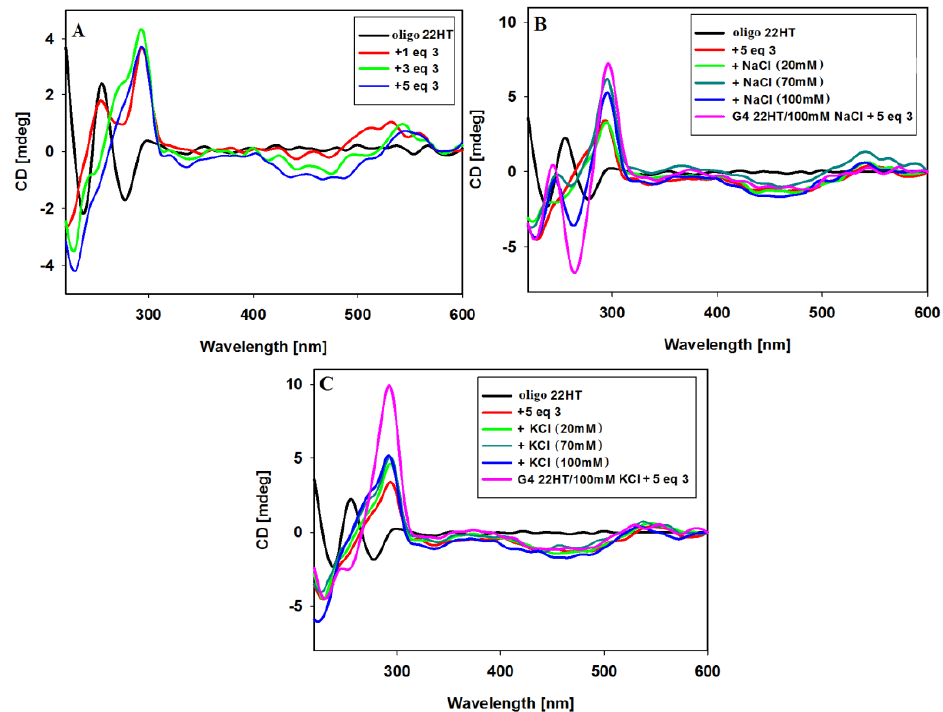
Figure 8. CD spectra of 22HT oligonucleotide (5 µ M) with increasing amounts of ligand 3 in Tris-HCl buffer (10 mM, pH 7.2) ( A ); CD spectra of 22HT oligonucleotide (5 µ M) with 5 equiv. of ligand 3 in Tris-HCl buffer and increasing amounts (0–100 mM) of NaCl ( B ) and KCl ( C ).